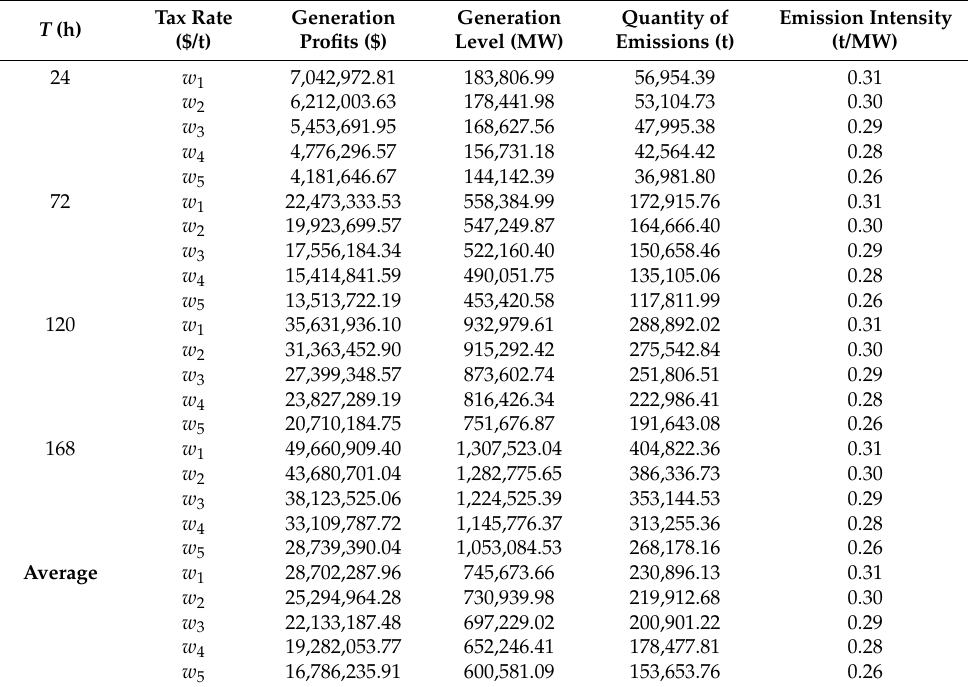
Table 5. Total generation profits, total generation level, the quantity of total emissions, and emission intensity under the carbon-tax policy with a constant tax